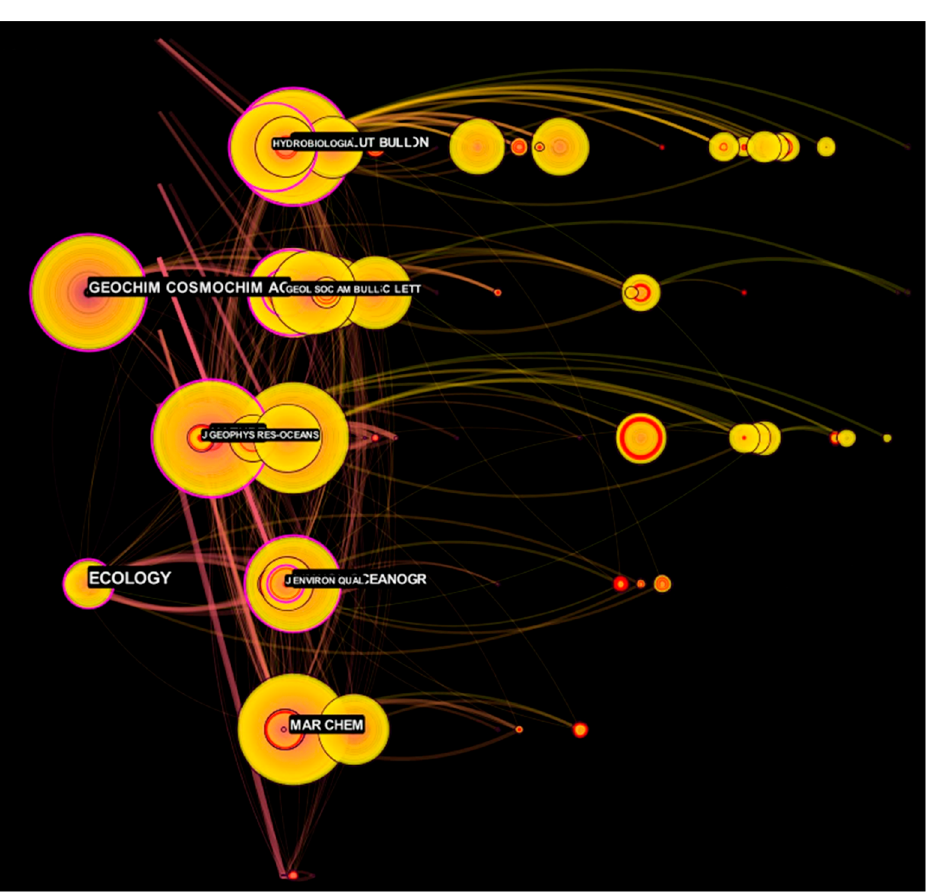
Figure 7. The most cited journals in studies related to the impacts of climate change on heavy metal contamination in coastal areas, based on the Web of Science Core Collection database (1979–2021).